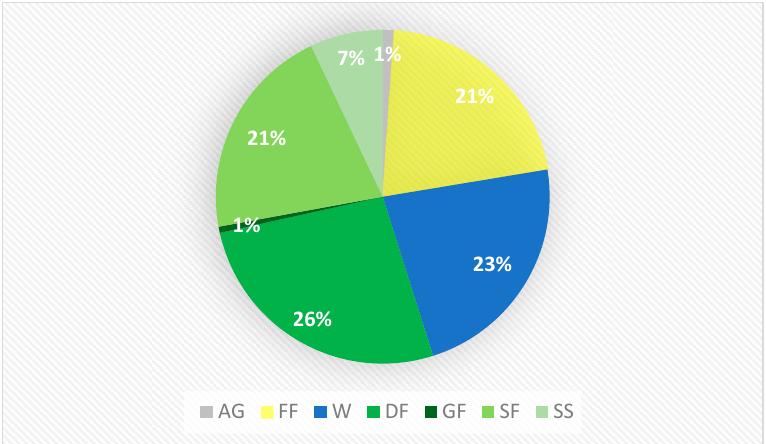
Figure 8. Simulated areas of land use units in the Ouémé Delta in 2035. AG: Agglomeration; FF: Fields and fallows; W: Water; DF: Dense forest; GF: Gallery forest; SF: Swamp forest; SS: Shrubby tree savannah.